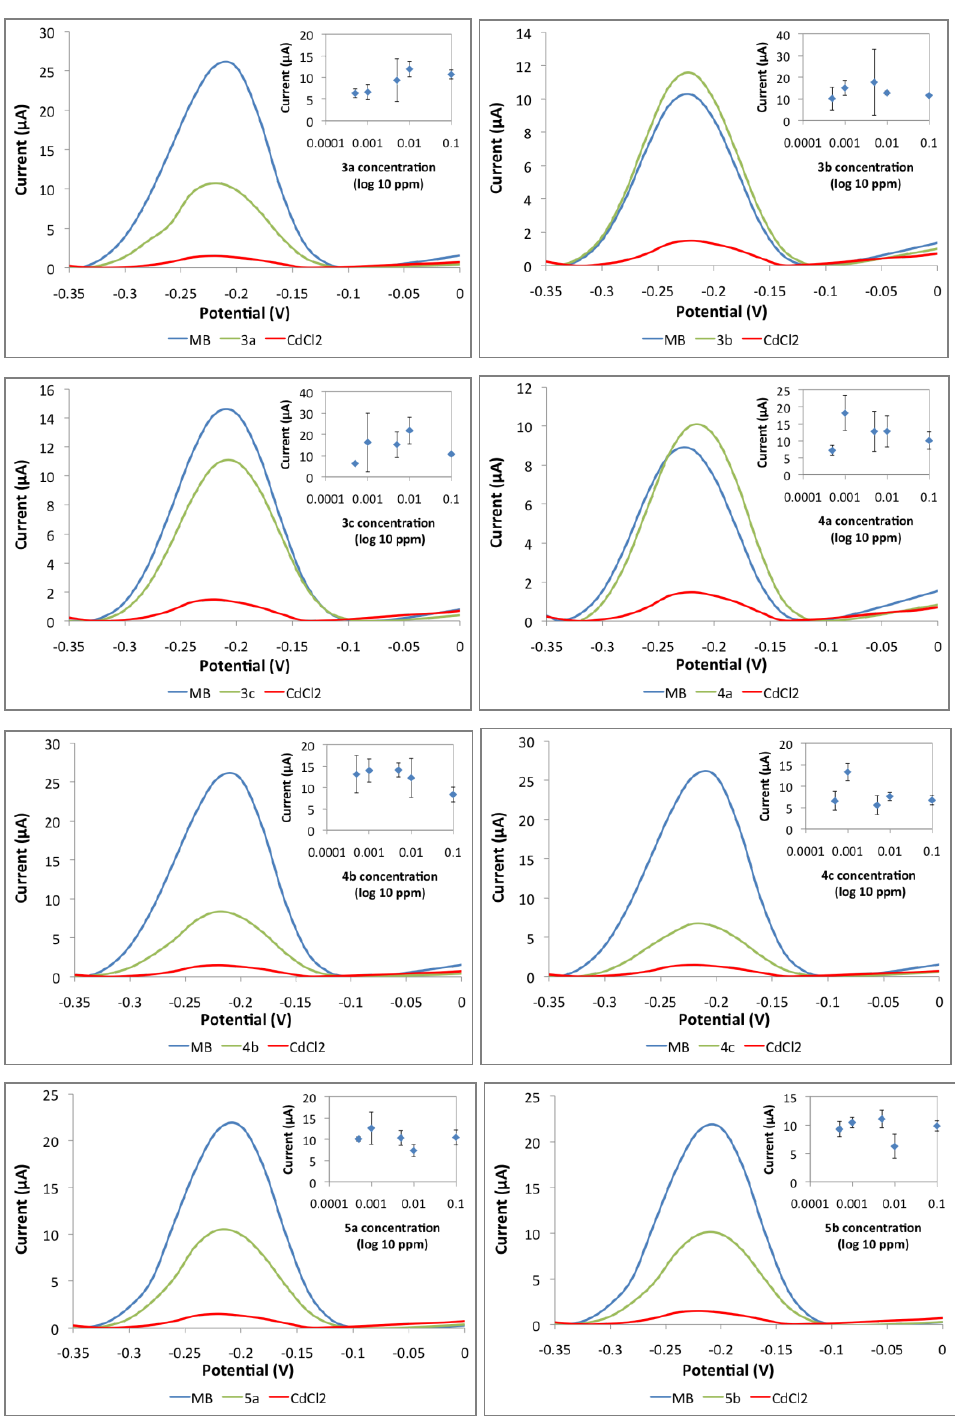
Figure 10. Performance of DNA biosensor with phthalides and bisindoles compounds; 3-[(1,3,3- Trimethylindolin-2-ylidene)methyl]isobenzofuran-1(3 H )-one ( 3a ), 3-[(5-Chloro-1,3,3-trimethylindolin- 3-[(1,3,3-Trimethylindolin-2-ylidene)methyl]isobenzofuran-1(3 H )-one ( 3a ) 2-ylidene)methyl]isobenzofuran-1(3 H )-one ( 3b ), 6,7-Dimethoxy-3-[(5-chloro-1,3,3-trimethylindolin-2- ylidene)methyl]isobenzofuran-1(3 H )-one ( 3c ), 3-(1-Methylindol-3-yl)isobenzofuran-1(3 H )-one ( 4a ), 3-(5-Bromo-1-methylindol-3-yl)isobenzofuran-1(3 H )-one ( 4b ), 6,7-Dimethoxy-3-(5-bromo-1- methylindol-3-yl)isobenzofuran-1(3 H )-one ( 4c ), 2-(Bis(1-methylindol-3-yl)methyl)benzoic acid ( 5a ) and2-(Bis(5-bromo-1-methylindol-3-yl)methyl)benzoic acid ( 5b ). * Large error bars show the non-carcinogen